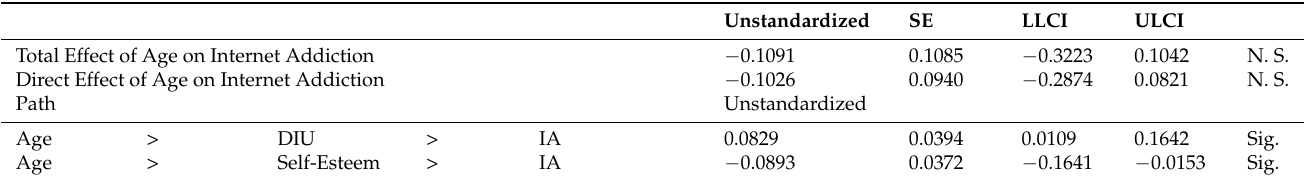
Table 4. Total, direct, and indirect regression analysis on internet addiction.